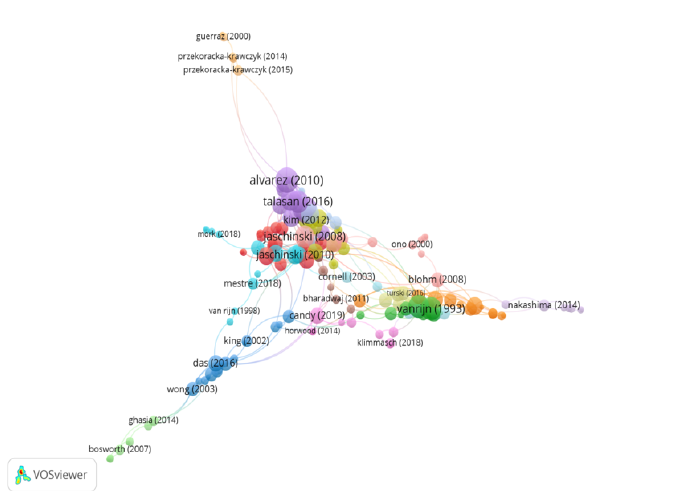
Figure 10. Citation network in Group